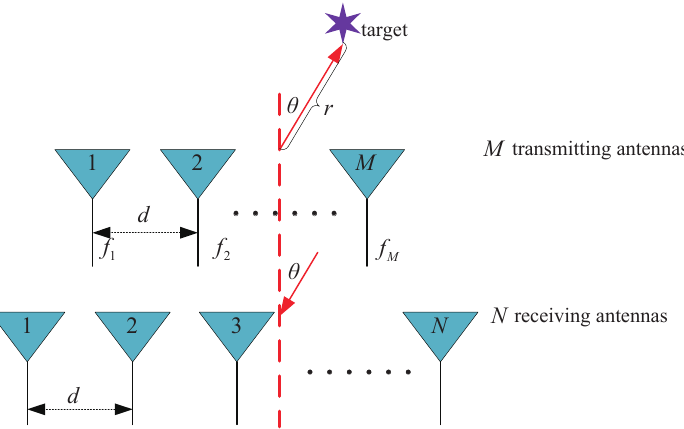
Figure 1. Schematic diagram of monostatic FDA-MIMO